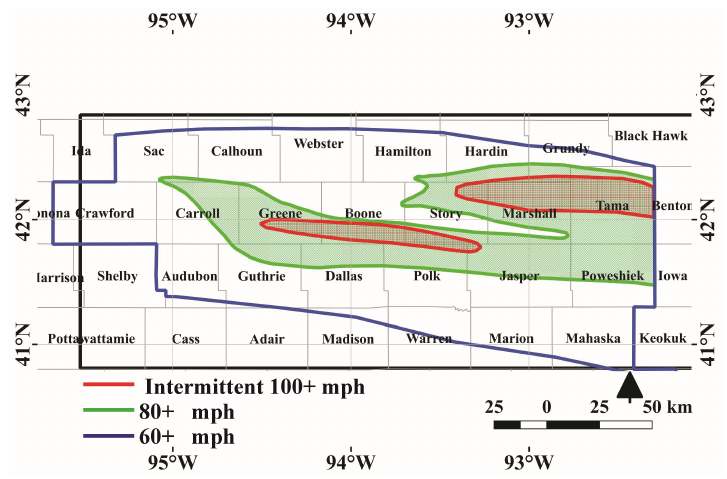
Figure 2. Wind speed data acquired from the National Weather Service (NWS). Table 1. Details of Sentinel-1A images acquired over Iowa and Illinois.